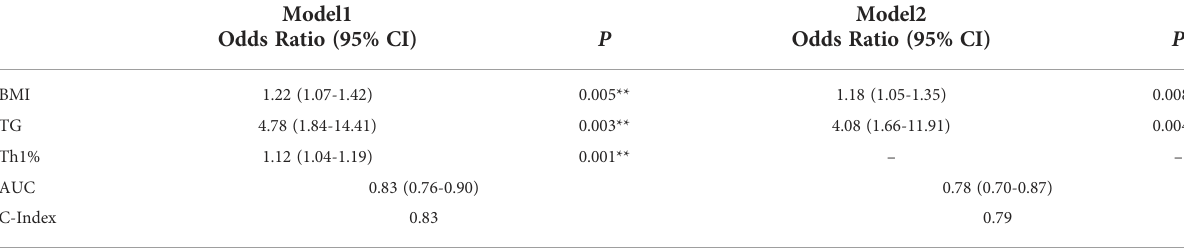
TABLE 3 Univariate logistic regression analyses for factors associated with the presence of NAFLD in PsA